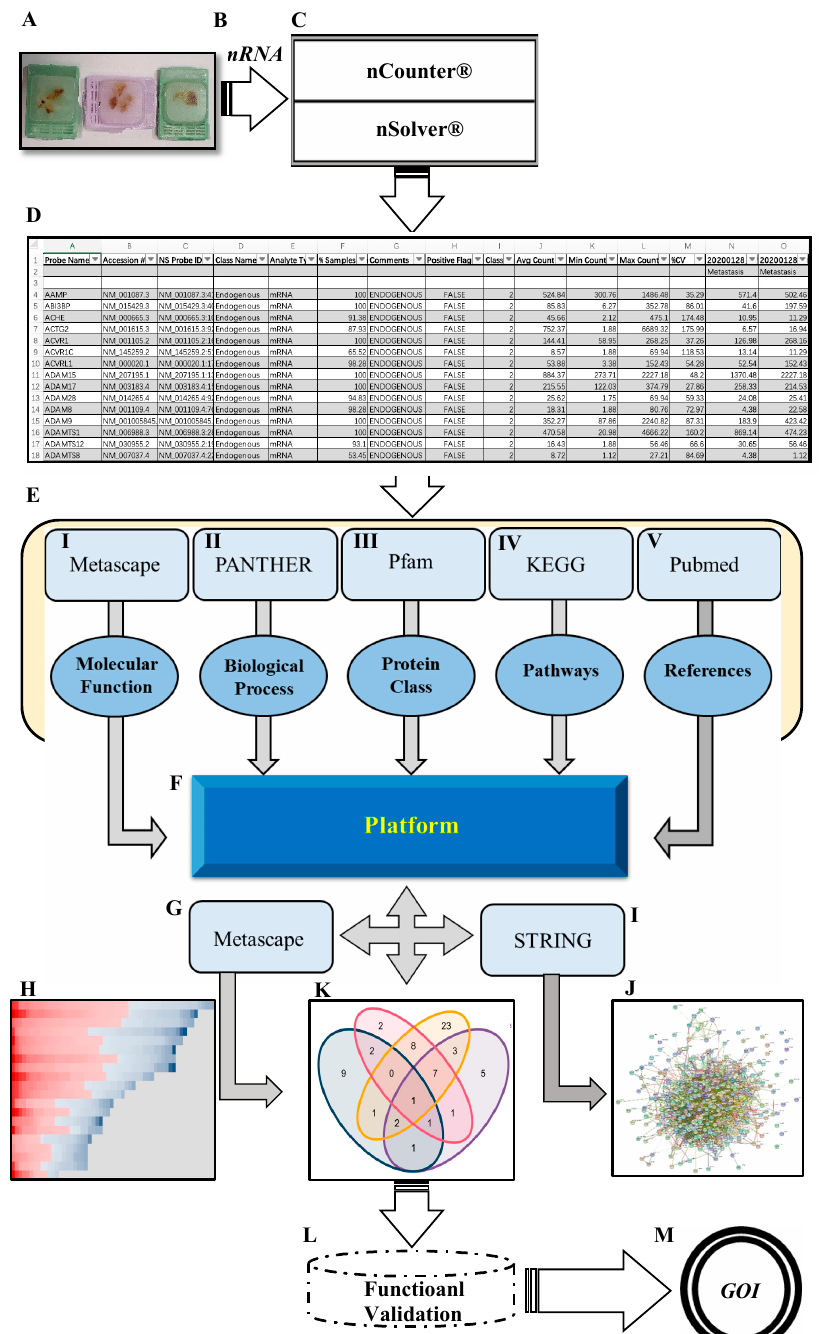
Figure 1. Schematic overview of the workflow. ( A ) FFPE tissue from PCa BM patients. ( B ) High quantity and quality of mRNA extracted from FFPE. ( C ) Fully-automated gene expression assay utilizing nCounter™ digital analyzer followed by nSolver™ NanoString technology v4.0. ( D ) Data output obtained from nSolver™ analyzer software. ( E ) Manual annotation and data enrichment procedure of DEGs: (I) Metascape for molecular function enrichment (metascape.org), (II) PANTHER for biological processes enrichment (pantherdb.org), (III) protein family using Pfam database (pfam.xfam.org), (IV) pathway enrichment retrieved from KEGG (genome.jp/keg), and (V) extracting publication for each gene by using related keywords (pubmed.ncbi.nlm.nih.gov). ( F ) The MACNP stands for Manually Annotated and Curated Nanostring-data Platform for 116 DEGs (PCa BM vs. primary PCa). ( G , H ) Further enrichment and clustering DEGs based on the interaction be- tween MACNP platform and Metascape. ( I , J ) Protein–protein interaction (PPI) of DEGs analysis produced by String (string-db.org) and Cytoscape (Cytoscape.org). ( K ) Venn diagram representing